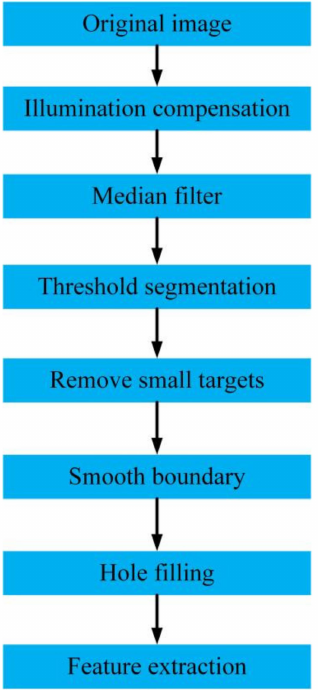
Figure 3. Diffraction fingerprint image pre-processing